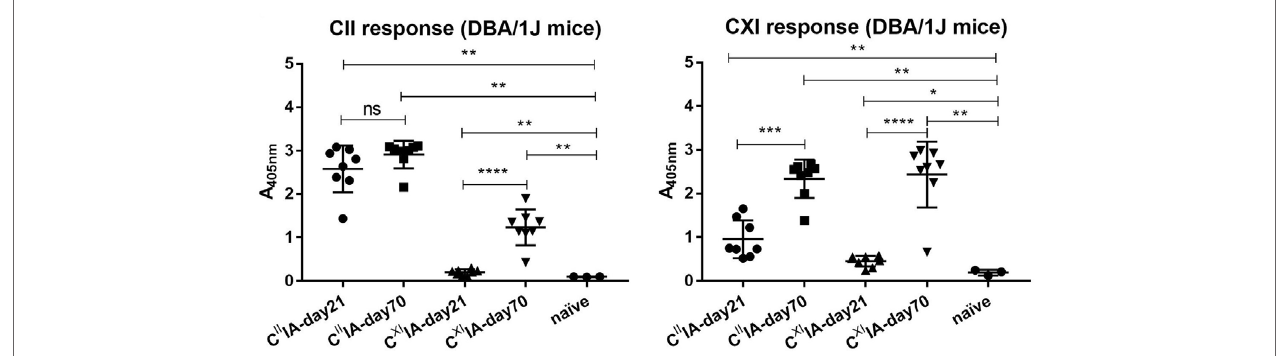
FigUre 1 | Serum antibody response to native CII and CXI in C II IA and C XI IA mice. Serum antibody response to native CII (left panel) and CXI (right panel) protein on day 21 or day 70 were measured in C II IA and C XI IA DBA/1J mice using enzyme-linked immunosorbent assays (ELISA). Naïve mice sera samples were served as negative control. Mann–Whitney U -test was used for group